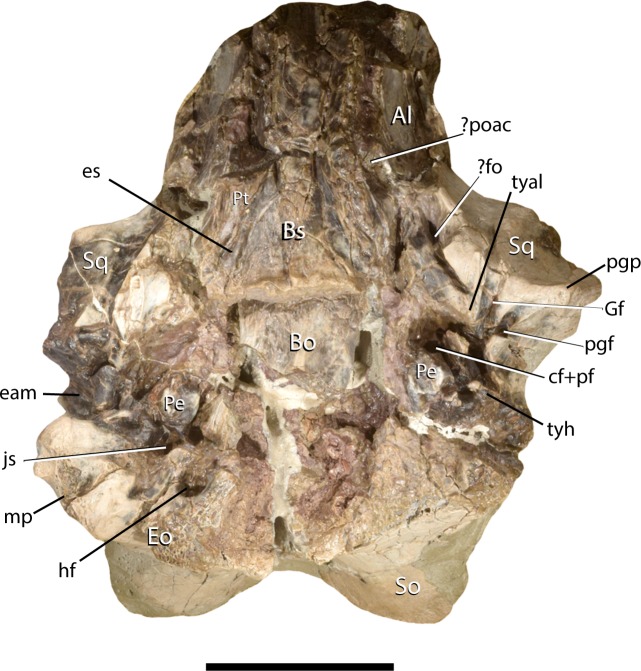
Basicranium of Periptychus carinidens (AMNH 3669) in dorsal view.Abbreviations: Al, alisphenoid; Bo, basioccipital, Bs, basisphenoid; cf, carotid foramen; eam, external acoustic meatus; Eo, exoccipital; es, Eustachian sulcus; fo, foramen ovale; Gf, Glaserian fissure; hf, hypoglossal foramen; js, jugular sulcus; mp, mastoid process; pe, petrosal; pf, pyriform fenestra; pgf, postglenoid foramen; pgp, postglenoid process; poac, posterior opening of the alisphenoid canal; pt, pterygoid; Sq, squamosal; tyal, tympanic process of the alisphenoid; tyh, tympanohyal; ?, denotes uncertainty of label. Scale bar: 30mm.